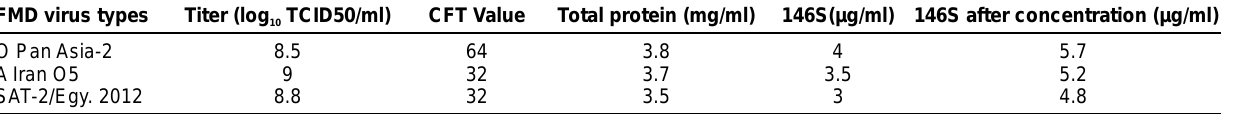
Table-1 . FMD virus titer, CF value, total protein and 146S concentration FMD virus types